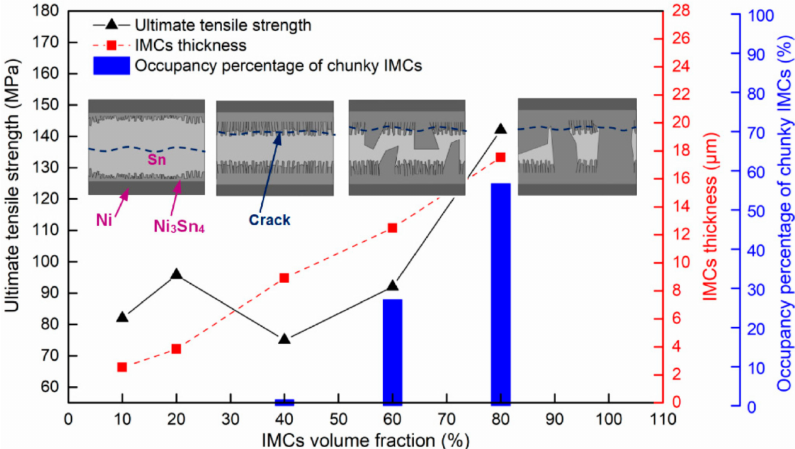
Figure 11. Relationships between the IMC microstructure and the micro-joints’ tensile mechanical properties, where schematic diagrams of the possible fracture path are also